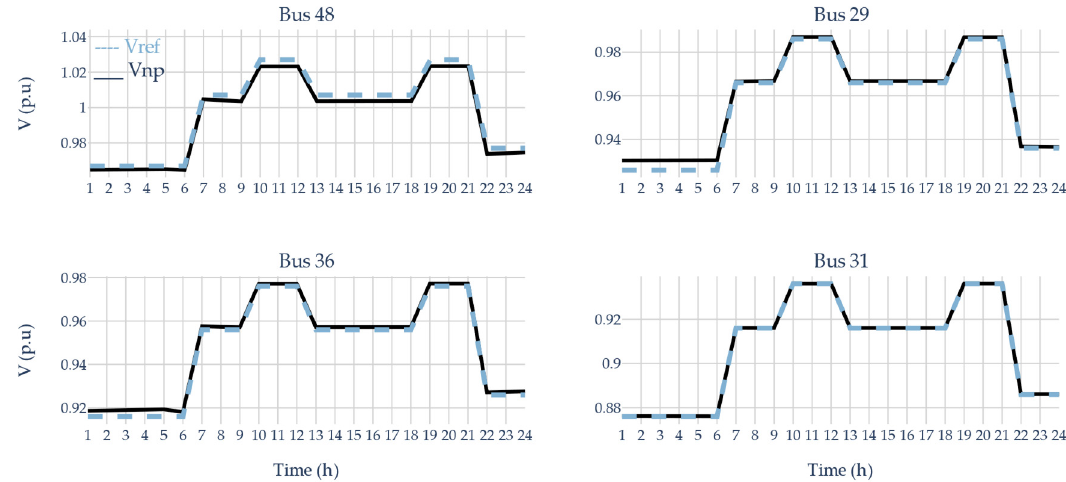
Figure 4. Voltage profiles of pilot nodes (48, 29, 36, and 31) for IEEE 57-bus system.